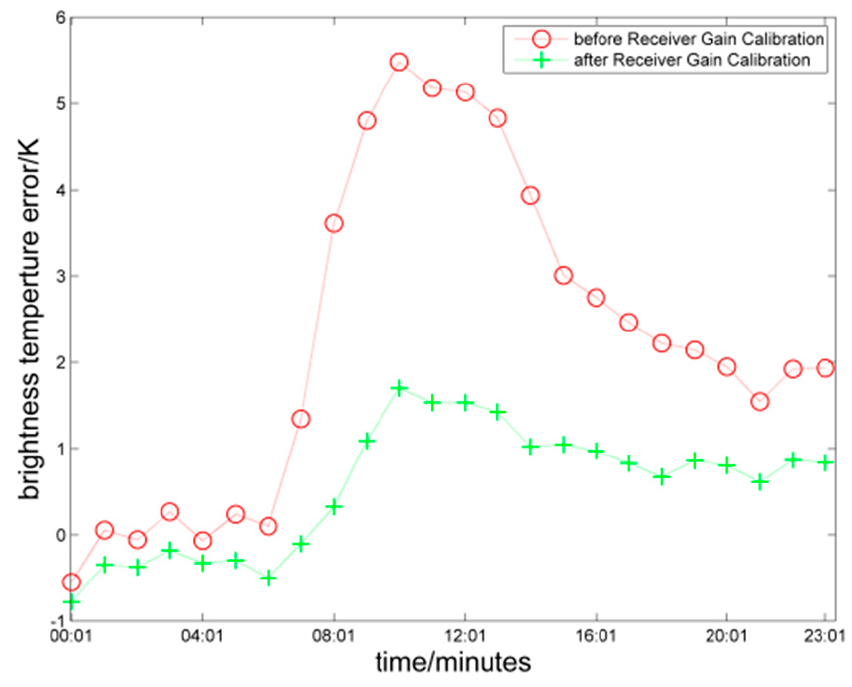
Figure 7. The error of measuring blackbody after receiver gain error calibration was reduced by nearly 1 K.